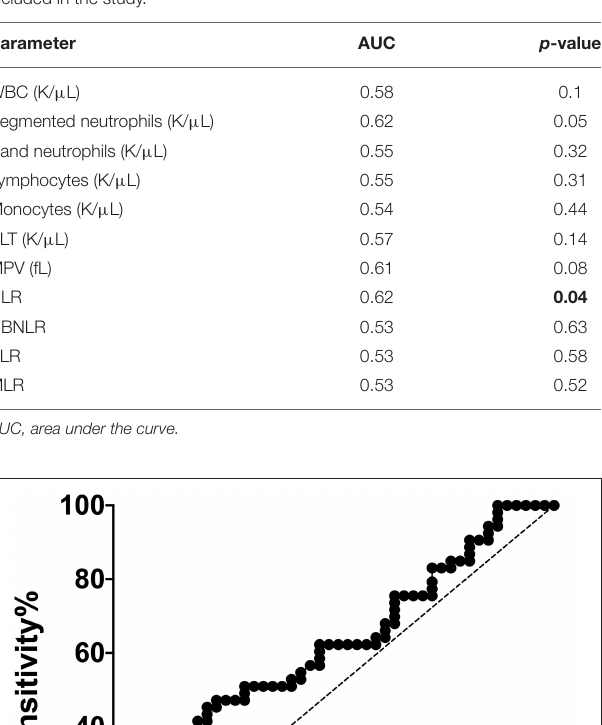
TABLE 1 | Results from the univariable analysis between septic and SIRS dogs.